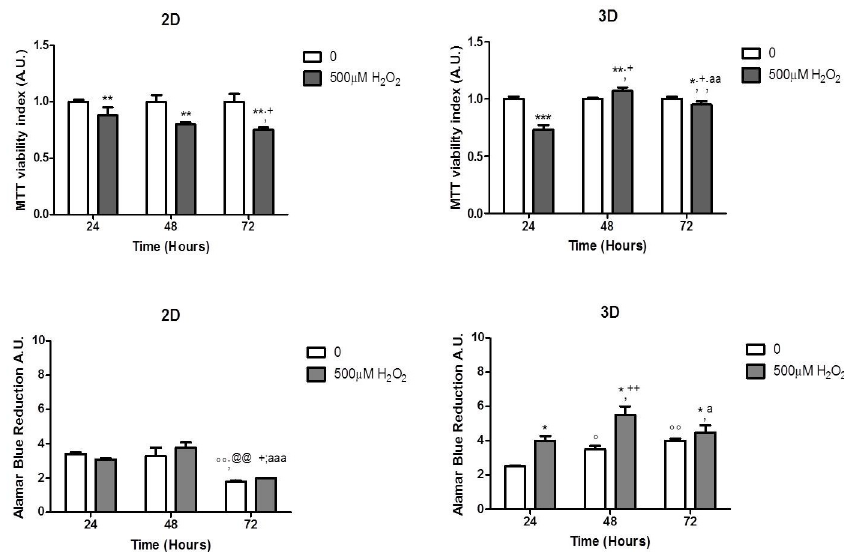
Fig 2. Effects of chronic H 2 O 2 treatment on HTMC metabolic activity. Panel A- Mitochondrial respiratory functionality. MTT assay was performed in 2D- and 3D-HTMC exposed to H 2 O 2 (500 μ M) for 24, 48 and 72 hrs. Panel B- Metabolic state of untreated and H 2 O 2 treated 2D and 3D HTMC cultures, during experimental treatments, was evaluated by Alamar blue assay. Data are expressed as A.U. of MTT test and of resazurin reduction of each HTMC cultures, and represent the mean ± S.D of 3 separated experiments, in triplicate. � p < 0.05 treated vs respective untreated cultures;˚p < 0.05,˚˚p < 0.01 untreated 48 and 72 hrs vs untreated HTMCs 24 hrs; @@ p < 0.01 untreated 72 hrs vs untreated HTMCs 48 hrs; +p < 0.01 treated 48 and 72 hrs vs treated HTMCs 24 hrs; a p < 0.05, aa p < 0.01; aaa p < 0.001 treated 72 hrs vs treated HTMCs 48 hrs. (Two-way ANOVA followed by Bonferroni posttest).